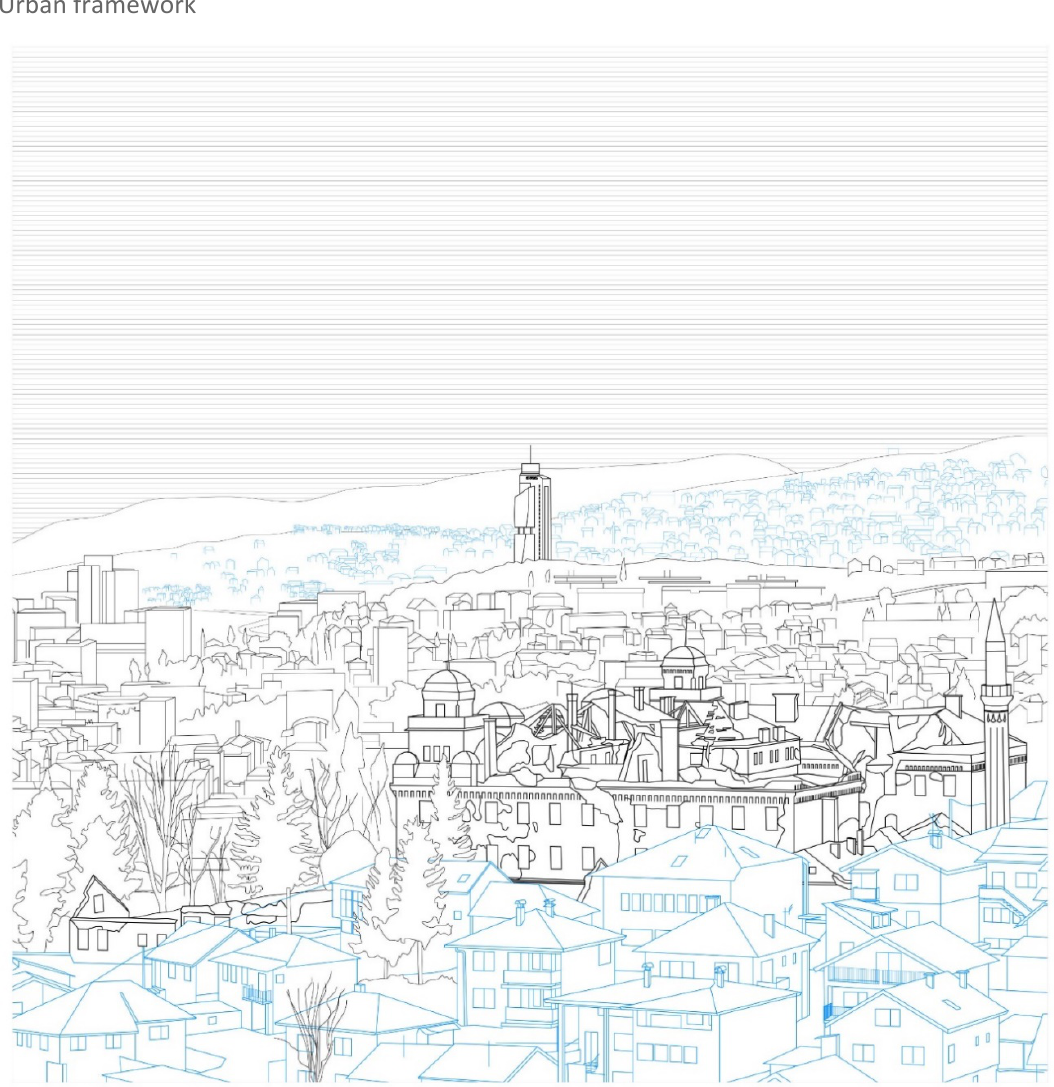
Figure 1: Sarajevo: Vratnik mahala (foreground in blue) and Aziz Tower (background in black) seen from Bijela Tabija, east of the Stari Grad and looking west toward modern city developments and